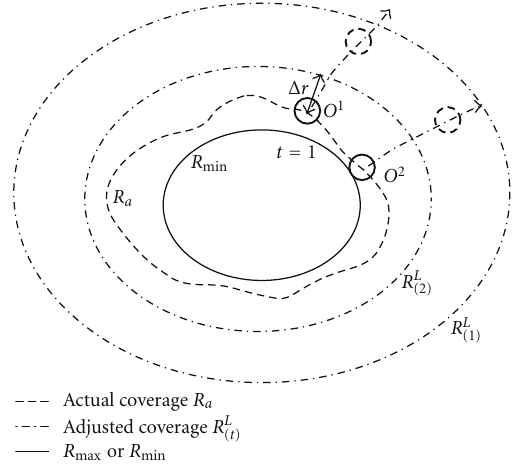
Figure 6: Illustration of coverage reduction when objects enter the coverage of an identification sensor.